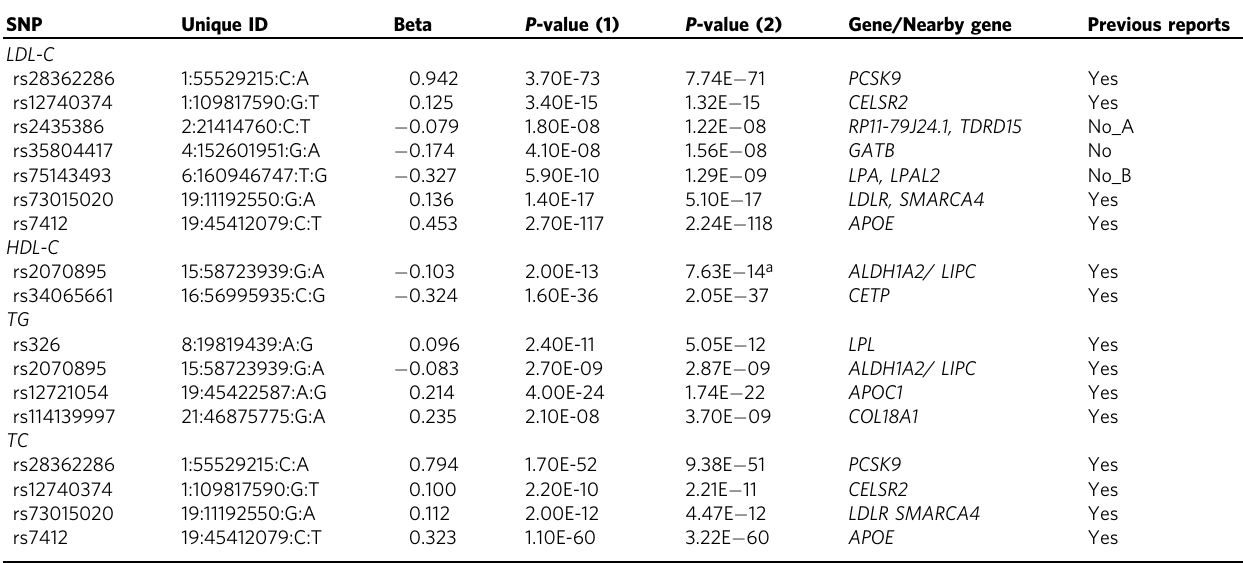
Fig. 1 Summary of the datasets and analyses. For each lipid trait, Stage 1 of the GWAS involved a joint analysis of the full AWI-Gen dataset (10,603 participants from Eastern, Western and Southern Africa) and Stage 2 ( N = 23,718) involved a meta-analysis of the Stage 1 results with the summary statistics from four African cohorts included in the Gurdasani et al. 2019 7 study (Uganda Genome Resource (UGR) study, the Africa-America Diabetes Mellitus (AADM) study, the Durban Diabetes Study (DDS), the Durban Case Control (DCC) study). Approximate geographic location and sample size of the cohorts are represented by position and size of the circles in the map. Each cohort is shown in a unique colour. Assessment of transferability of associations detected in the Global Lipid Genetics Consortium (GLGC) 15 study and the Population Architecture using Genomics and Epidemiology (PAGE) 36 study was performed in various replication sets. Predictability of polygenic risk score models based on Gurdasani et al. 2019 7 , GLGC 15 and PAGE 36 was assessed in the AWI-Gen dataset. The map was created using R (https://www.r-project.org/). Table 1 Summary of associations detected in the Stage 1 GWAS for the four lipid traits.